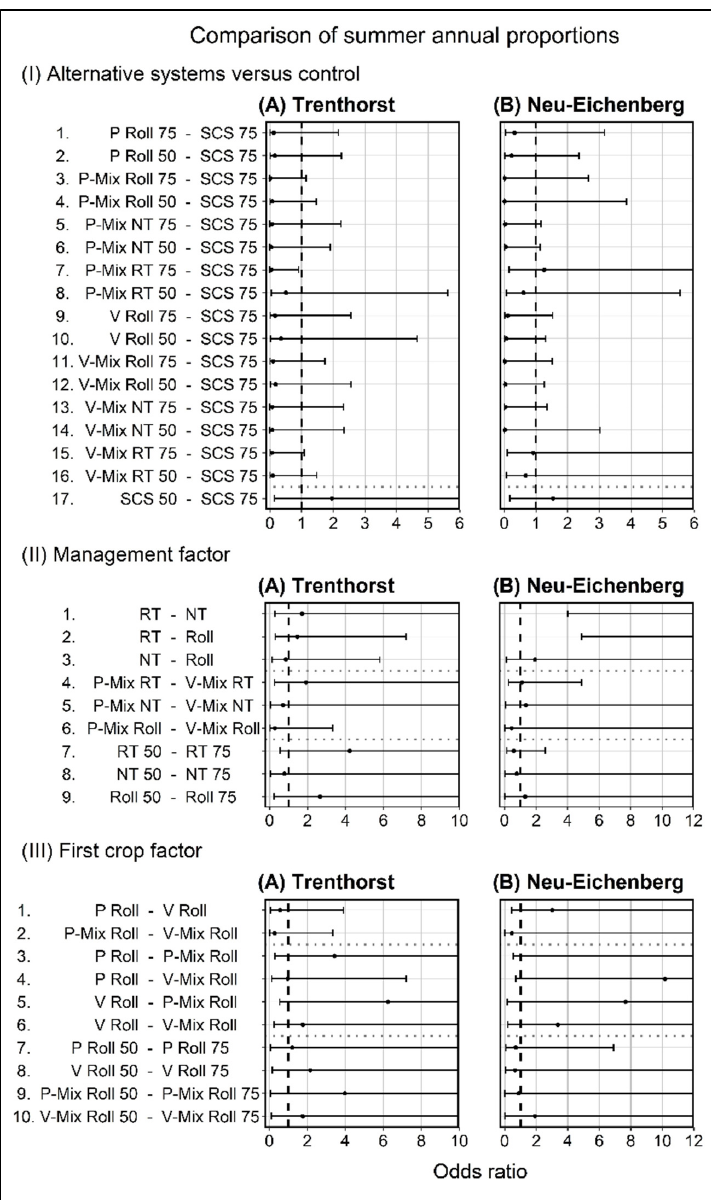
Figure A1. Comparison of summer annuals averaged over year at the two locations with the focis: ( I) Alternative systems versus control, ( II ) Management factor, ( III ) First crop factor. The contrast in question is shown on the y-axis, whereas its scale is on the x-axis. Factor levels for first crop are: P = winter pea, V = hairy vetch, P-Mix and V-Mix = their mixtures with a cereal partner; for management are: SCS = control, RT = reduced tillage, NT = no tillage, Roll = rolling of first crop; and for row width are: 75 cm and 50 cm. Points represent odds ratios for treatment comparisons. The odds ratios were computed using exponential transformation of the linear contrasts of mean estimates on the logit-scale (log-odds scale). The vertical dashed lines at 1 show the H 0 , where the odds ratio of the estimates is 1 (estimated means are equal). Error bars show the 95% CI of the estimated difference after a multivariate t adjustment. Thus, when this crosses the vertical dashed line (H 0 ), there is statistically no or a non-significant difference between means at α = 0.05. Each focus group is analyzed independently. Please note that DCS NT treatments at TRE were only present in the second year. The odds ratio for NEB in focus ( II ) contrast 1 is 24.94, whereas for contrast 2, it is 48.11. The odds ratio for NEB in focus ( III ) contrast three is 23.18. These were cut off from the plots, so the H 0 line and the nearby points stay less